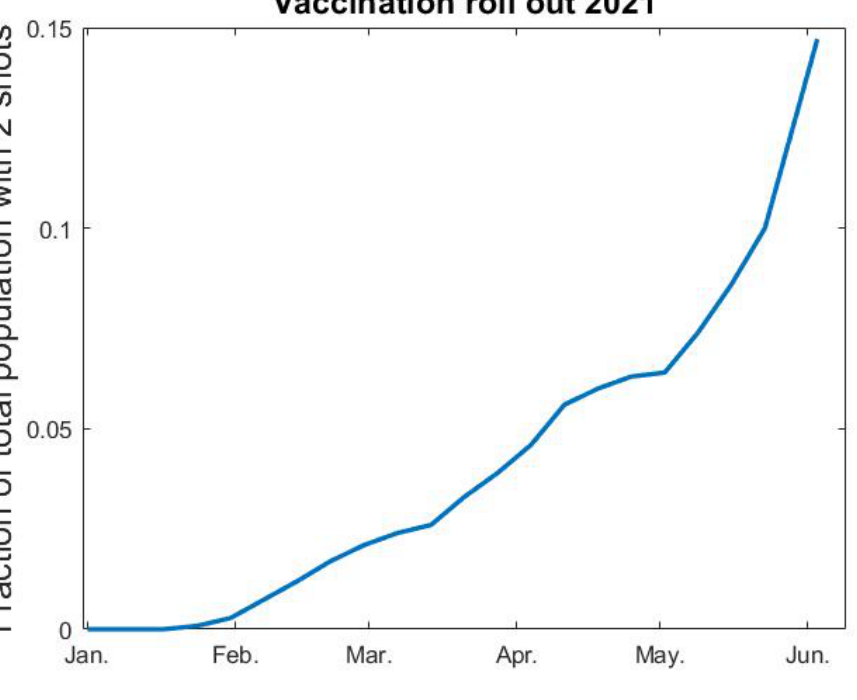
Figure A1. Fraction vaccinated v as function of time t